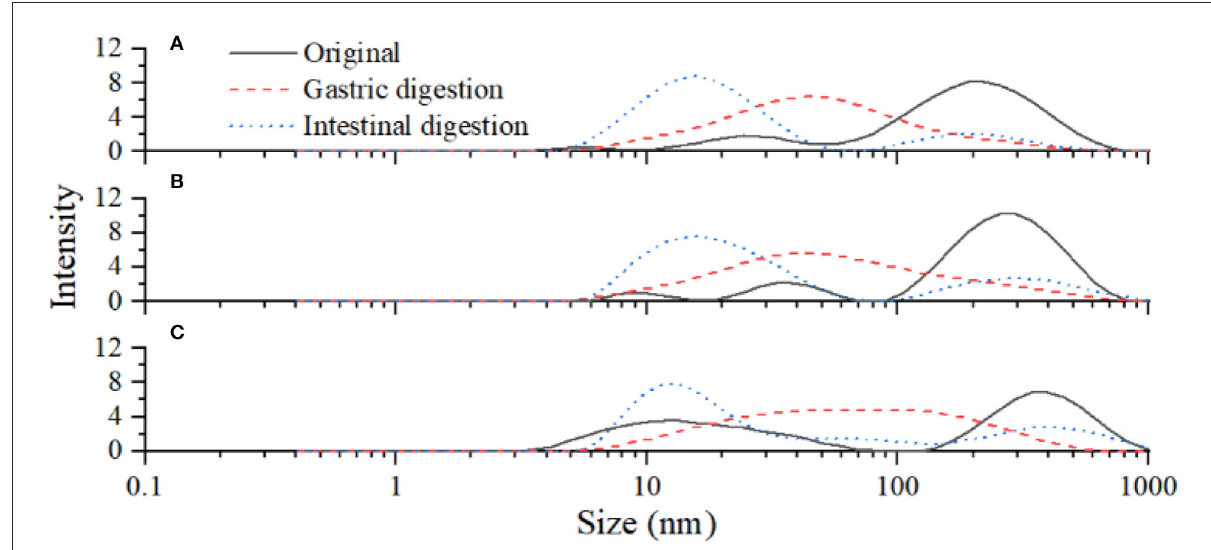
FIGURE6 Particle size distribution of glycated bovine serum albumin (BSA) after gastrointestinal digestion. L. plantarum group (A) , non-inoculated litchi pericarp oligomeric procyanidins (LPOPCs) group (B) , and inoculated LPOPCs group (C)